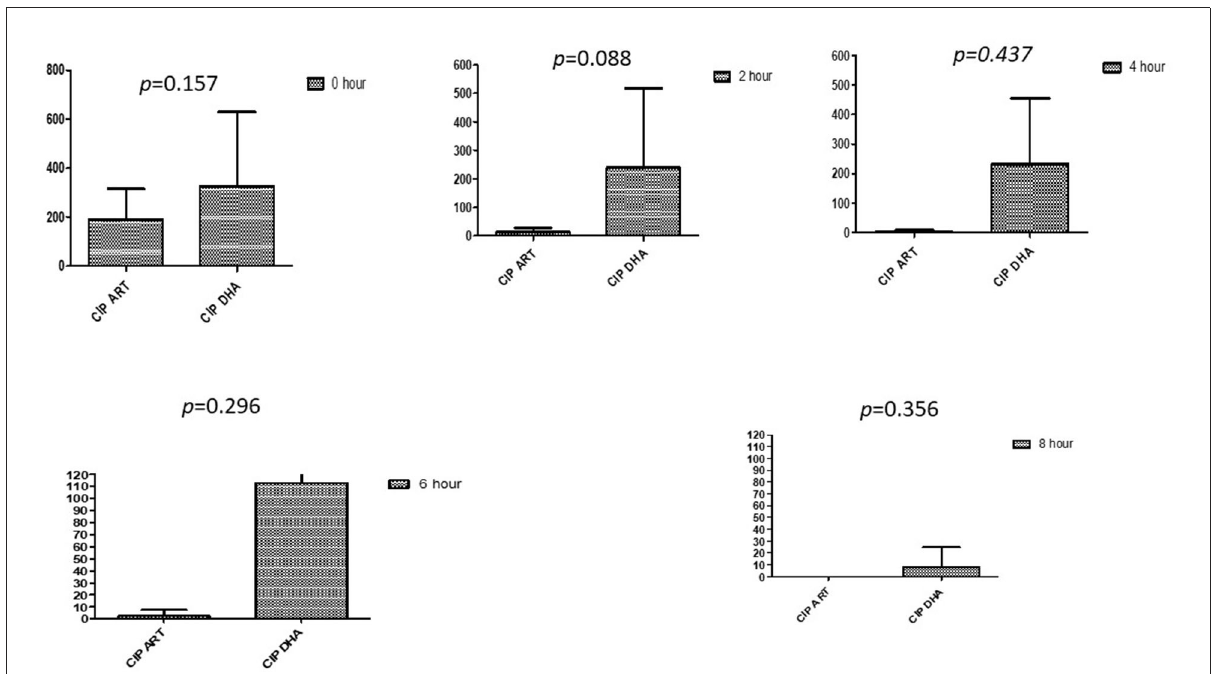
FIGURE1 Compare ciprofloxacin’s minimum inhibitory concentrations ( µ g/mL) when combined with ART and DHA on E. coli. CIP ART, Ciprofloxacin combined with ART; CIP DHA, Ciprofloxacin combined with DHA; p < 0.05 indicate a significant difference among MICs of antibiotic combined ART and DHA.